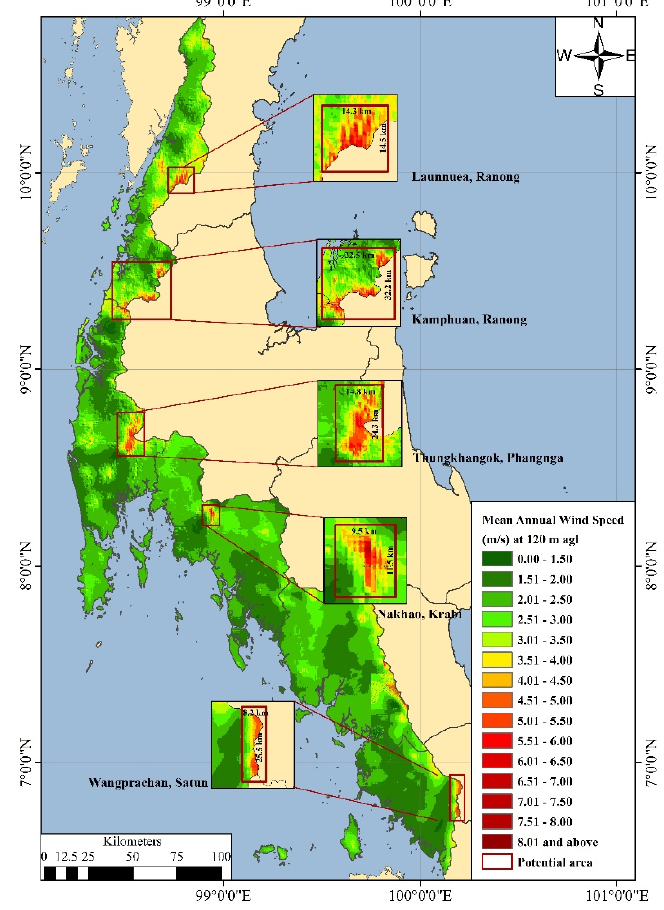
Figure 9. Mean annual wind speeds at 120 m agl of the potential sites for wind power development.